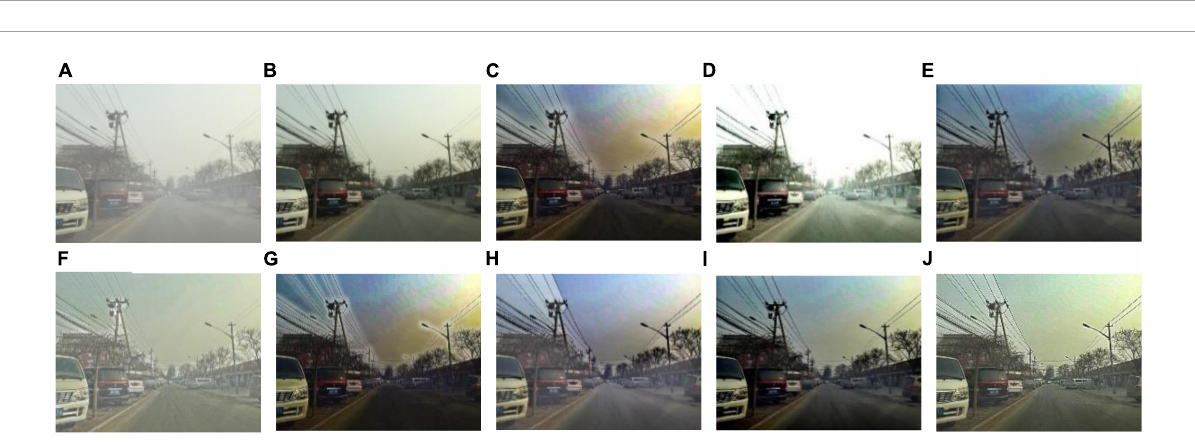
FIGURE10 Experimental results of different methods for Figure 3 : (A) input image; (B) ground truth; (C) dark channel prior; (D) Fattal et al.; (E) Meng et al.; (F) Tarel et al.; (G) Ehsan et al.; (H) Berman et al.; (I) Raikwar et al.; (J) proposed.